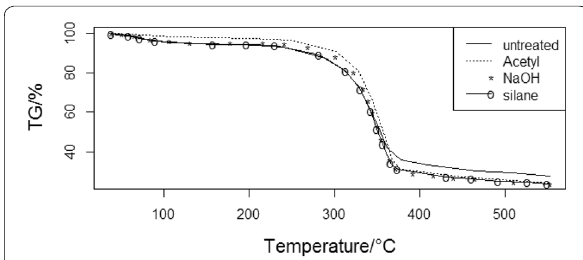
Fig. 5 TGA curves of the hemp fibers. a Compressive strength test. b Flexural strength test. c Splitting tensile strength